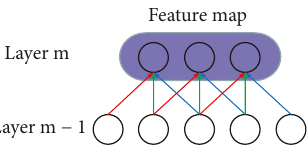
Figure 4: The schematic diagram of shared